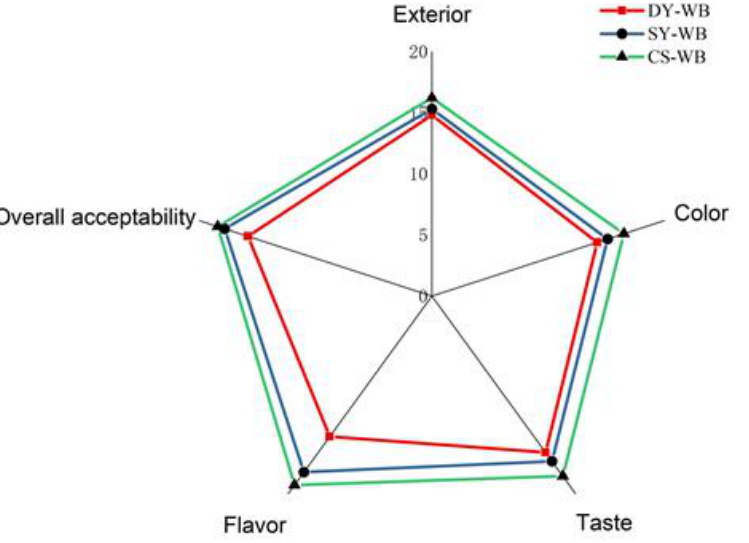
Figure 6. Radar image of sensory evaluation of different whole wheat steamed breads. Note: DY- WB — whole wheat steamed bread fermented by commercial dry yeast; SY-WB — whole wheat